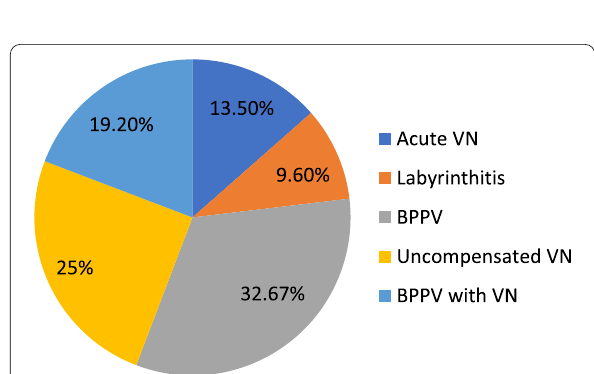
Fig. 4 Vestibular diagnosis based on history, bedside, and VNG